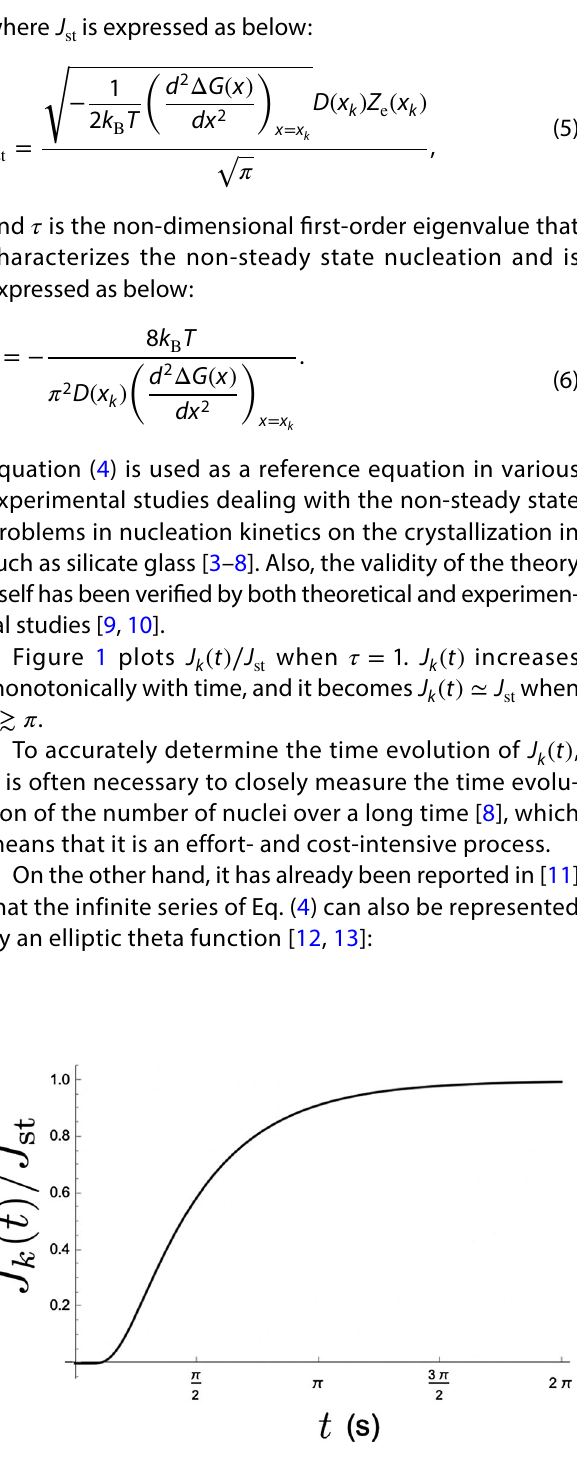
Fig. 1 The ratio of the non-steady state nucleation rate and the steady state nucleation rate J k ( t )∕ J st vs. time t (s) with the timescale of non-steady state nucleation 𝜏 =